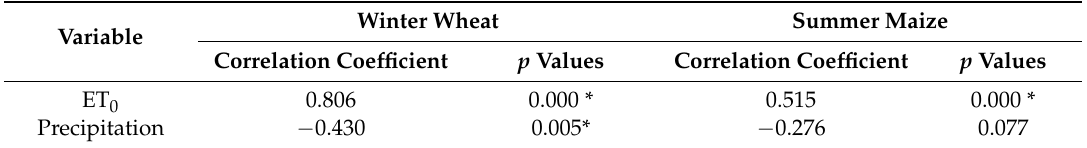
Table 10. Coefficients of correlation between irrigation and ET 0 , precipitation during different seasons. Winter Wheat Summer Maize Variable Correlation Coefficient p Values Correlation Coefficient p Values ET 0 0.806 0.000 * 0.515 0.000 * Precipitation − 0.430 0.005* − 0.276 0.077